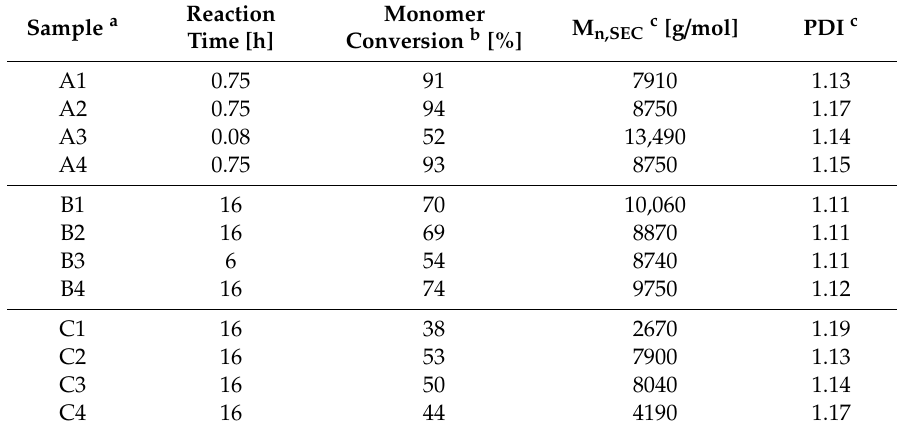
Table 3. Characterization of the synthesized poly( N -isopropylacrylamide) (PNIPAAm)